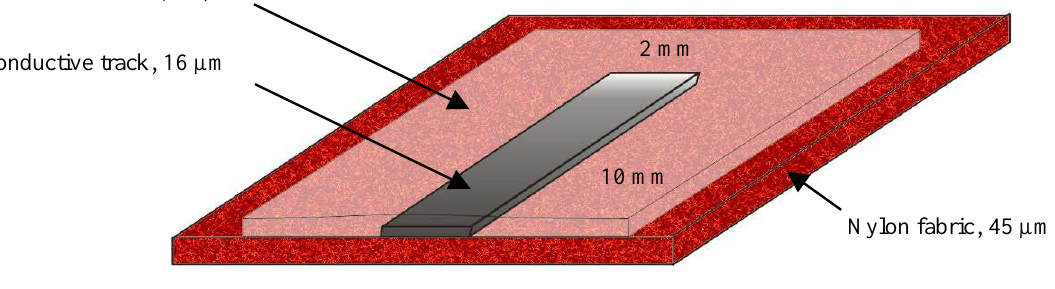
Figure 5. Schematic representation of the structure and dimensions of the sensor integrated on the fabric.